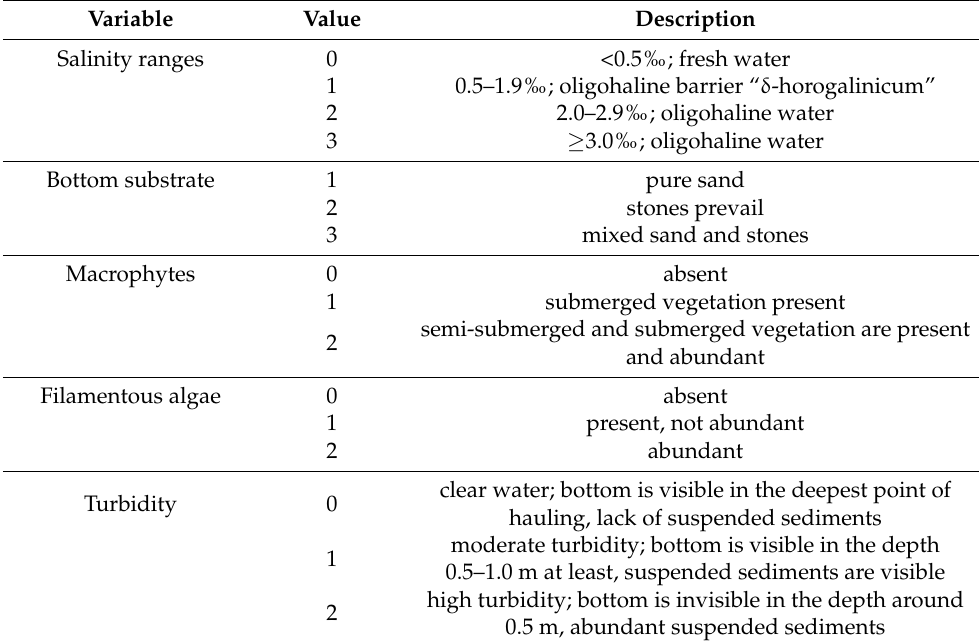
Table 1. Ranks of environmental variables estimated during the coastal samplings in